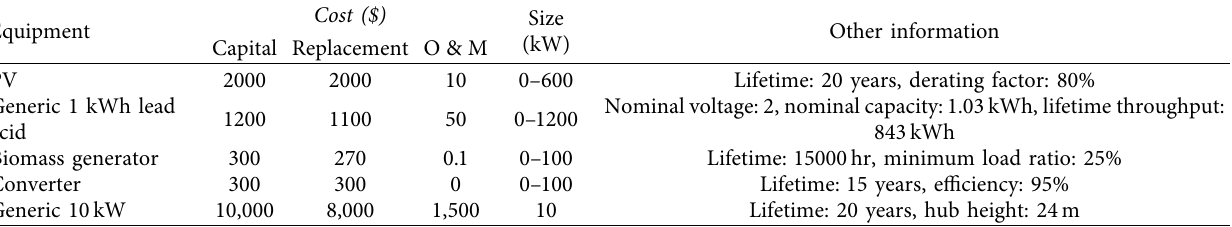
Figure 1: The schematic representation of the system under Table 3: Technical and economic information of the equipment used in the solar-diesel system [28, 29].